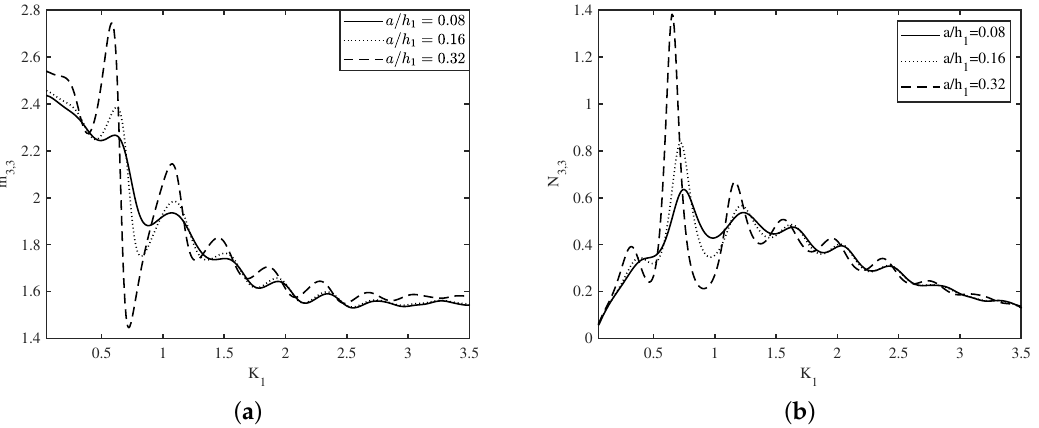
Figure 9. Variation of ( a ) m 3,3 and ( b ) N 3,3 vs K 1 for different a / h 1